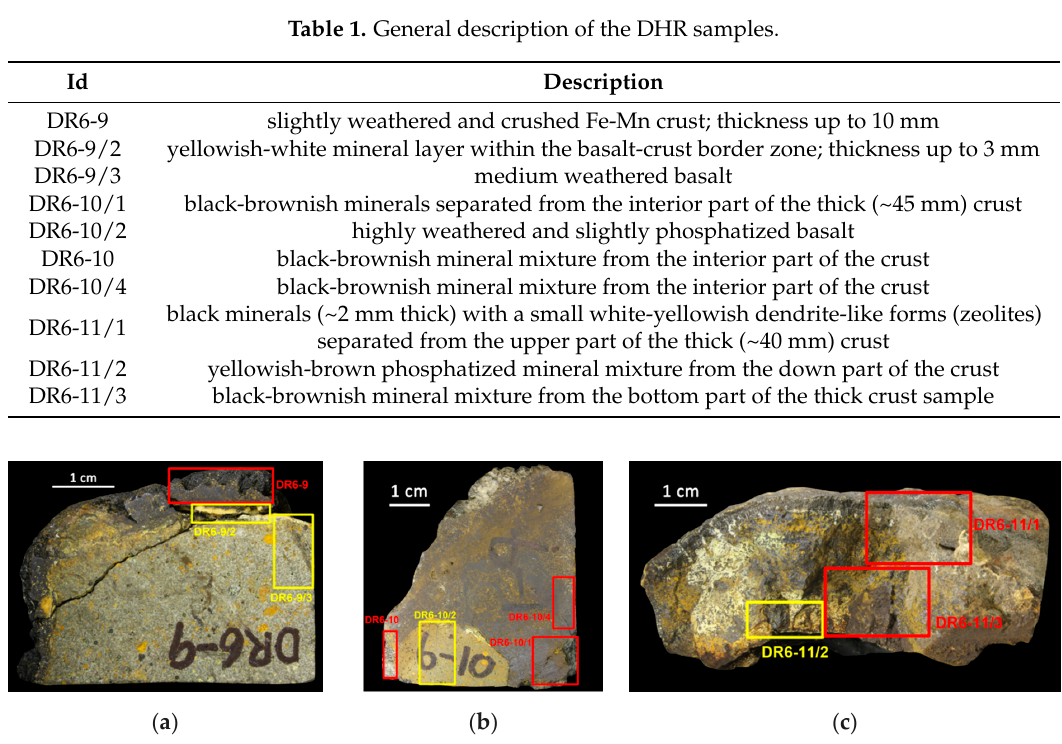
Table 1. General description of the DHR samples.